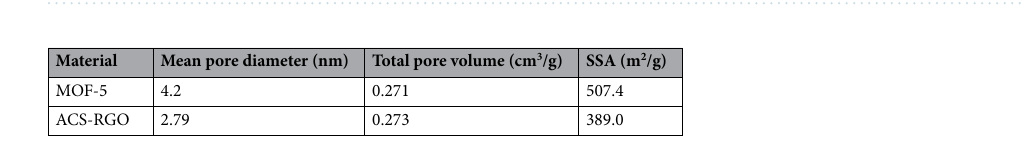
Figure 3. FTIR spectra for ACS-RGO, and MOF-5.